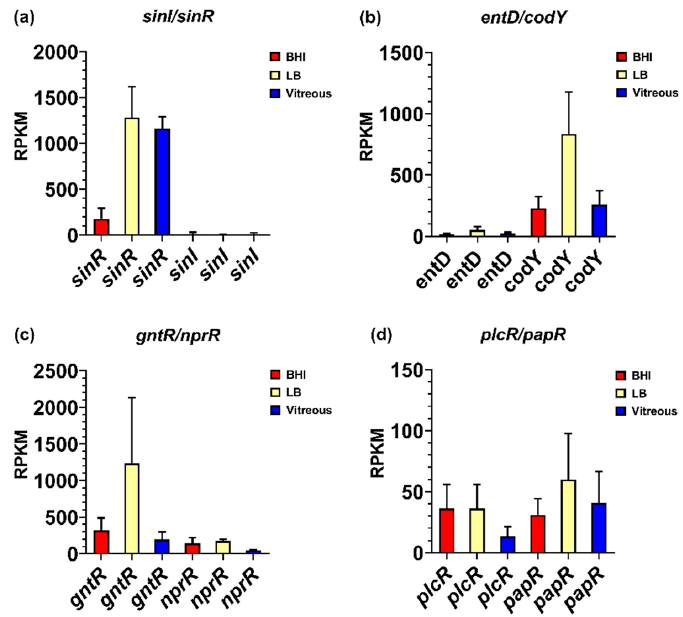
Figure 4. Normalized transcriptional regulatory gene expression in each of the three di ff erent environments. Reads per kilobase per million (RPKM) for the genes encoding transcriptional regulators SinI / SinR ( a ), EntD and CodY ( b ), GntR and NprR ( c ), and PlcR / PapR ( d ). Brain Heart Infusion broth (BHI) is shown in red, Luria-Bertani broth in yellow, and vitreous in blue. RPKM values are the means ± the standard deviations of three independent experiments RNA-Seq